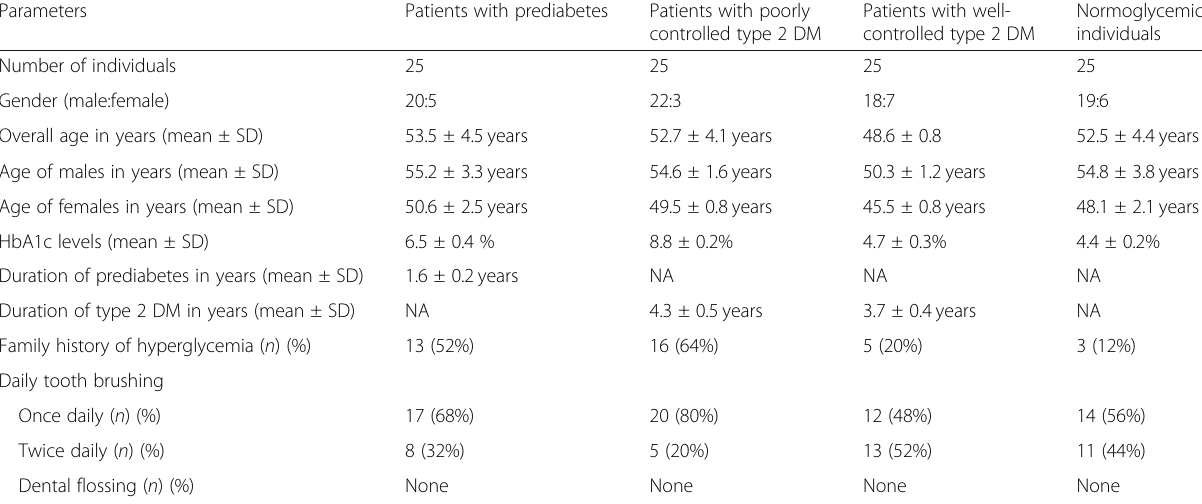
Table 1 Demographics of patients with prediabetes and type 2 diabetes mellitus and normoglycemic individuals Parameters